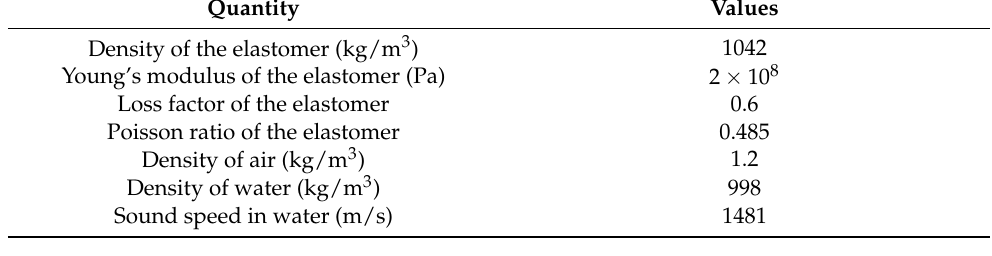
Figure 6. Schematic and geometric parameters of the hybrid sound-absorbing metastructure in fi- nite-element simulations. Figure 5. Simulation model for analyzing the sound absorption coefficient of the developed hybrid sound-absorbing metastructure: ( a ) simulation setup and ( b ) boundary conditions. Table 1. Parameters considered for the substrate of the developed metastructure [8].